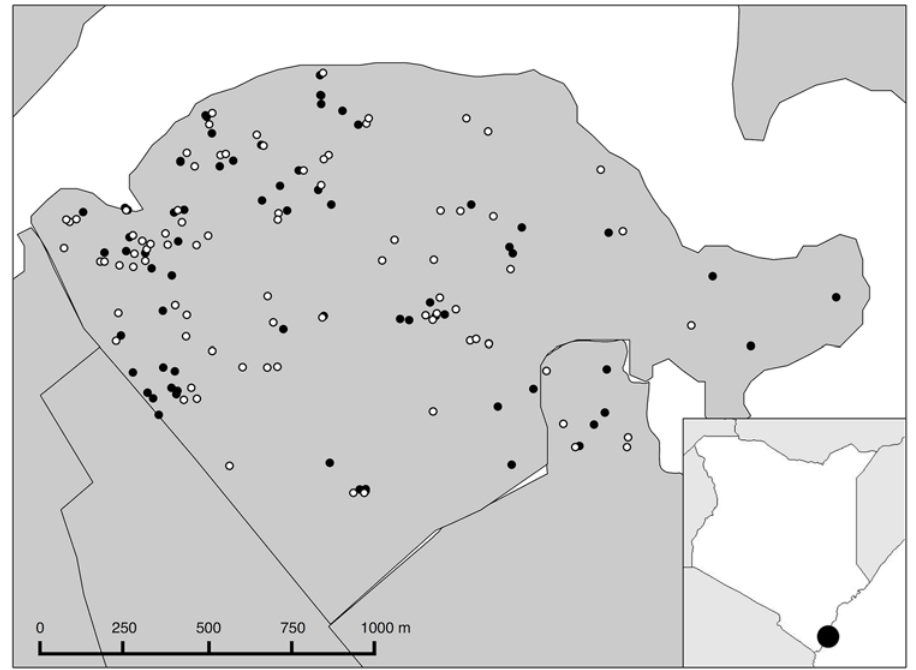
Fig 2. Map of 210 dengue virus (DENV) infected participants in Tudor, Mombasa, Kenya. Participants with evidence of current or recent DENV infection were distributed throughout the Tudor district, and there was no statistically significant clustering by area. Solid black circles represent IgM anti-DENV positive participants, white circles represent RT-PCR positive participants.